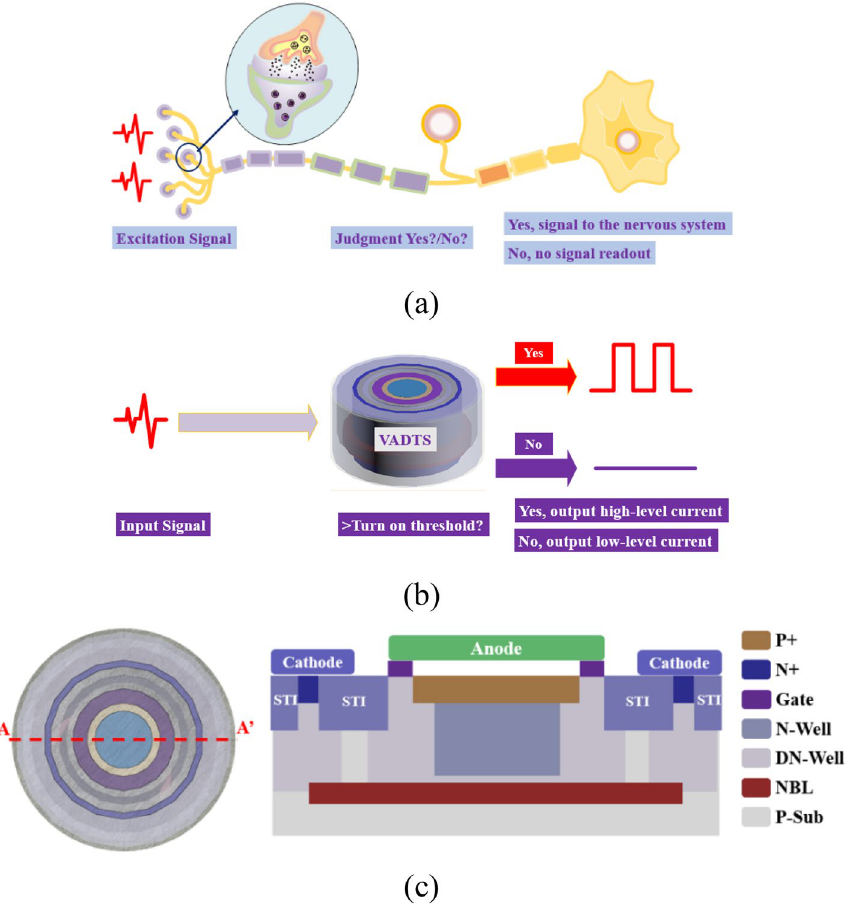
Figure 1. ( a ) The signal transmission mechanism of the nerve synapse. ( b ) The signal transmission mechanism of VADTS bionic nerve synapse. ( c ) The cross section of VADTS